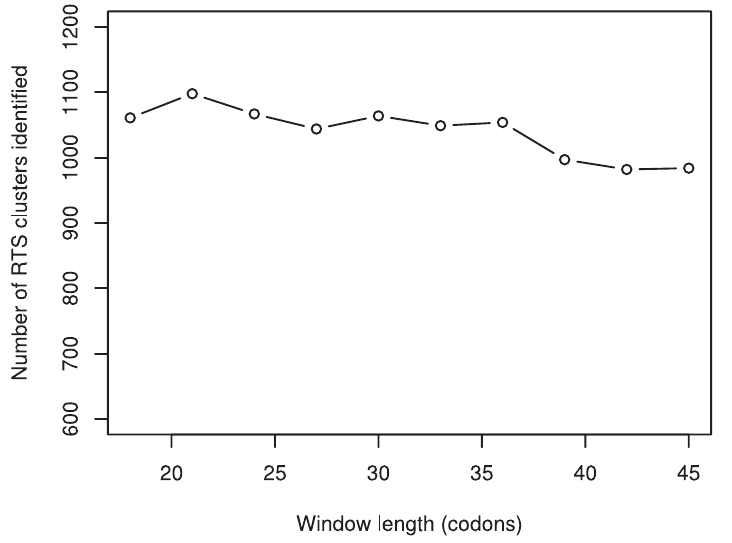
Figure 5. The sliding window analysis with increasing window sizes. The length of the windows employed in the sliding window analysis does not greatly affect the absolute number of significant RTS clusters identified in the dataset. However, the number of RTS clusters classified as significant decreases as the window size increases. This is expected if surrounding sequence that is not biased towards reducing the translation rate dilutes the effects of significant